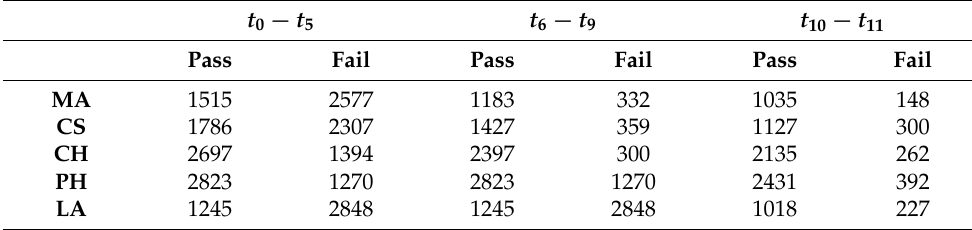
Table 5. Data samples per time